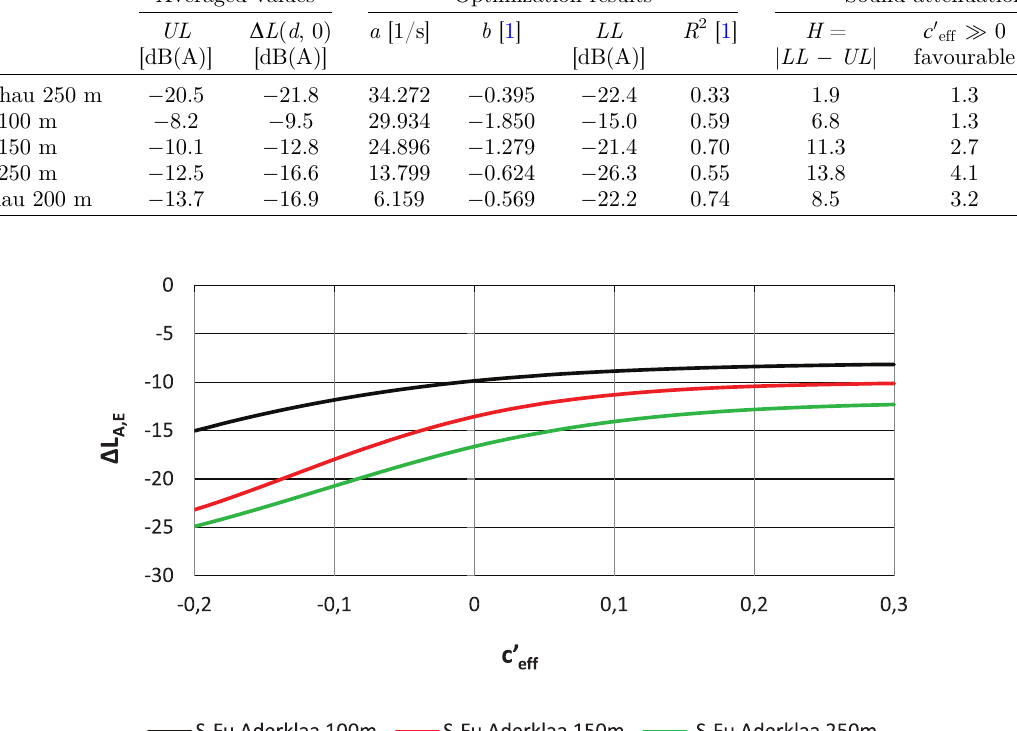
Figure 13. S-shaped sound attenuation versus c 0 eff for different distances at the railway line measurement site Aderklaa.